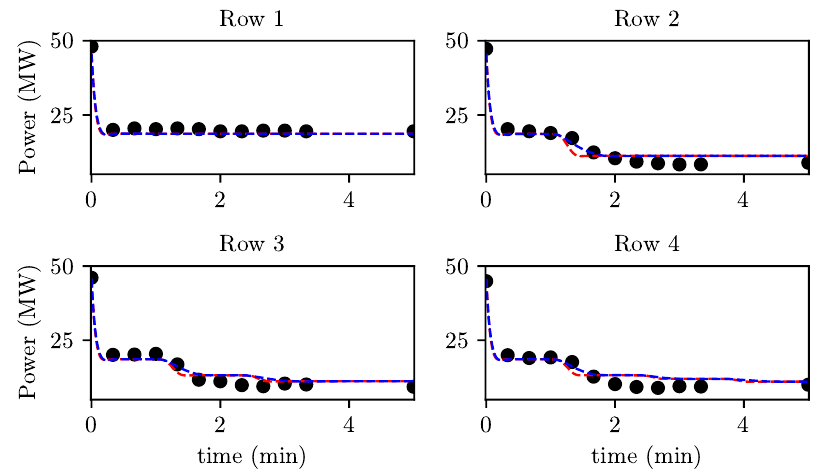
Figure 6. Power production of a wind farm at start-up comparing LES (symbols), the model with linear advection (red), and the model with nonlinear advection (blue). Only the first four rows of the farm are